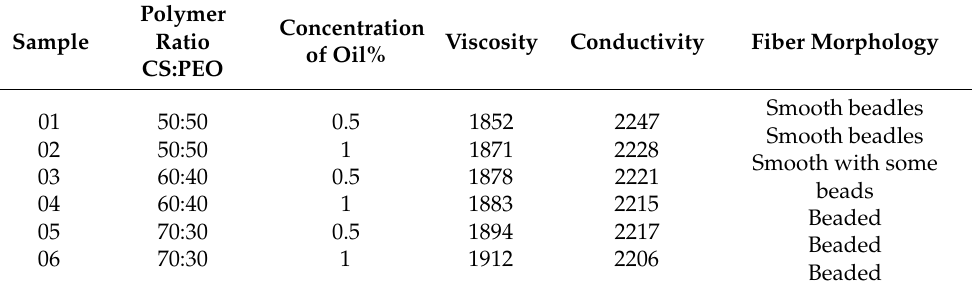
Figure 2. Average fiber diameters measured during formulation. Table 2. Viscosity and conductivity of electrospinning solution at various polymer ratio and oil concentrations.